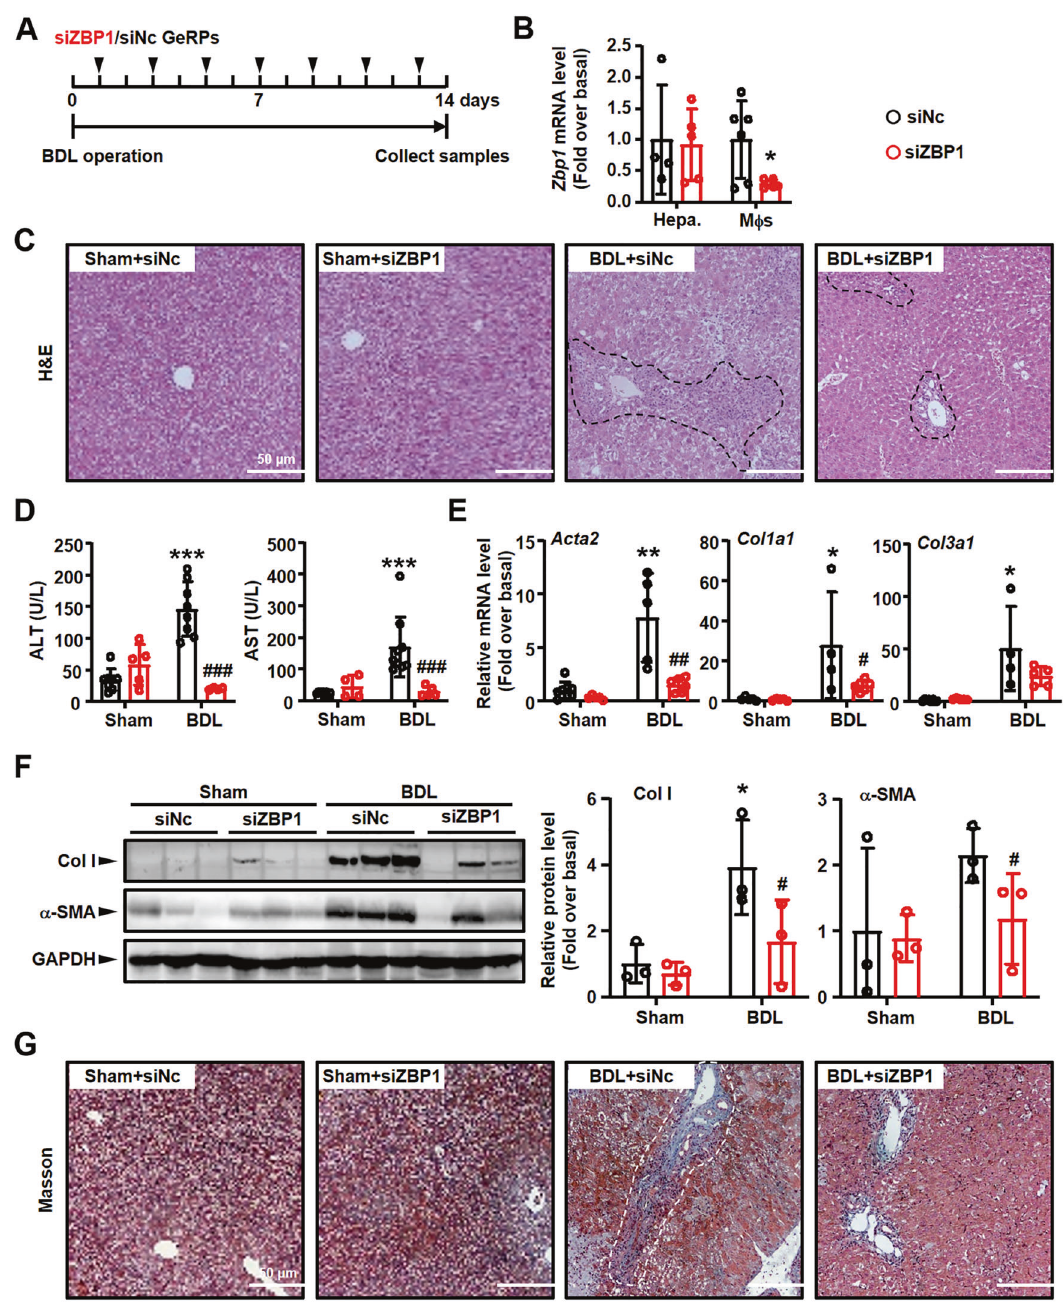
Fig. 9 Speci fi cally knockdown of macrophage Zbp1 alleviated in fl ammation/ fi brosis in BDL liver. A The schedule of mouse model. B mRNA expressions of Zbp1 in hepatocytes (Hepa.) and macrophages (M φ s) from BDL mouse livers treated with NC or Zbp1 siRNA-GeRPs. C Representative images of H&E staining. Black dashed: in fl ammation area. Scale bars: 50 μ m. D Serum AST and ALT levels were detected in NC and Zbp1 siRNA-GeRPs pretreated BDL livers. E mRNA expressions of fi brosis markers ( Acta2 , Col1a1 and Col3a1 ) were detected by qRT-PCR. F Western blot analysis for Col I and α -SMA in the liver tissues from BDL mouse livers treated with NC and Zbp1 siRNA-GeRPs. G Representative images of Masson staining. White dashed: collagen deposition area. Scale bars: 50 μ m. Data are presented as the mean ± SEM. * p < 0.05, ** p < 0.01, *** p < 0.001 (versus control). # p < 0.05, ## p < 0.01, ### p < 0.001 (versus BDL